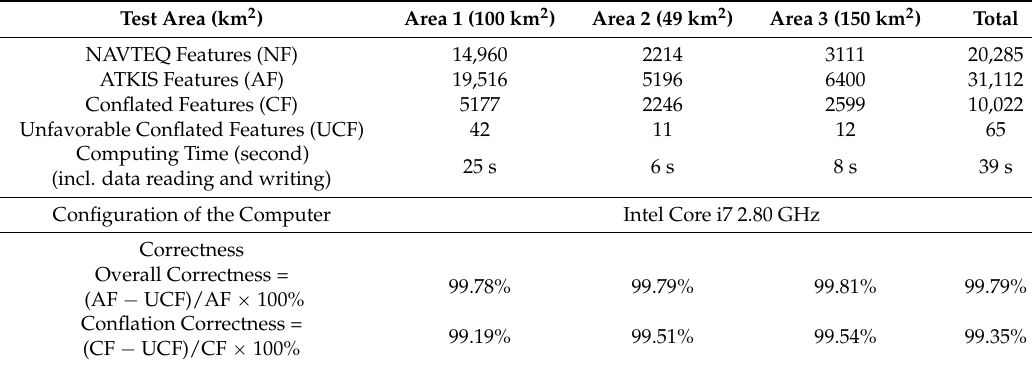
Table 1. Statistical results of the road-network conflation.